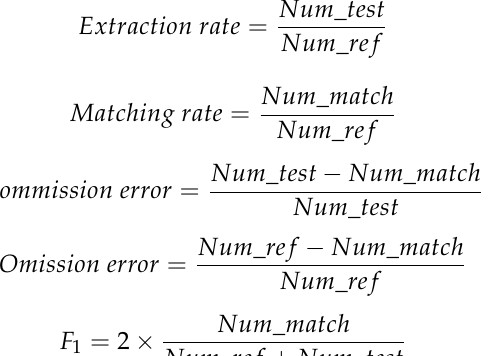
matching tree top. The numbers above the points indicate the elevation